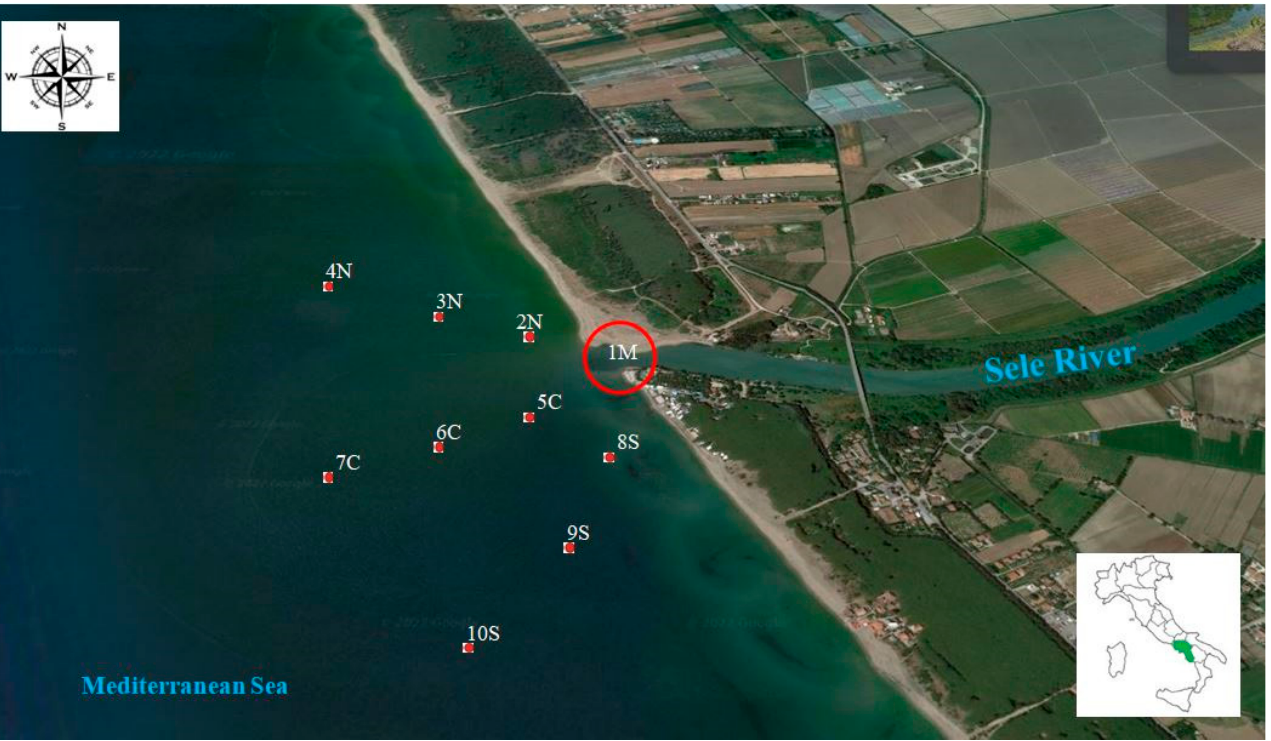
Figure 1. Study area in the Mediterranean Central Sea: solid dots show sampling stations from the Sele river and estuary, southern Italy.